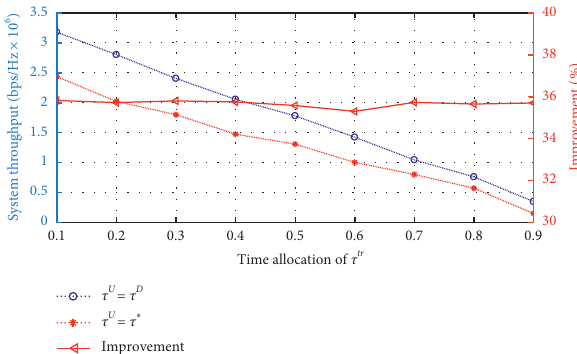
Figure 6: The relationship between probe time and the system throughput with L � 8, N � 2, σ 2 � − 50dBm/Hz, and η � 0 .